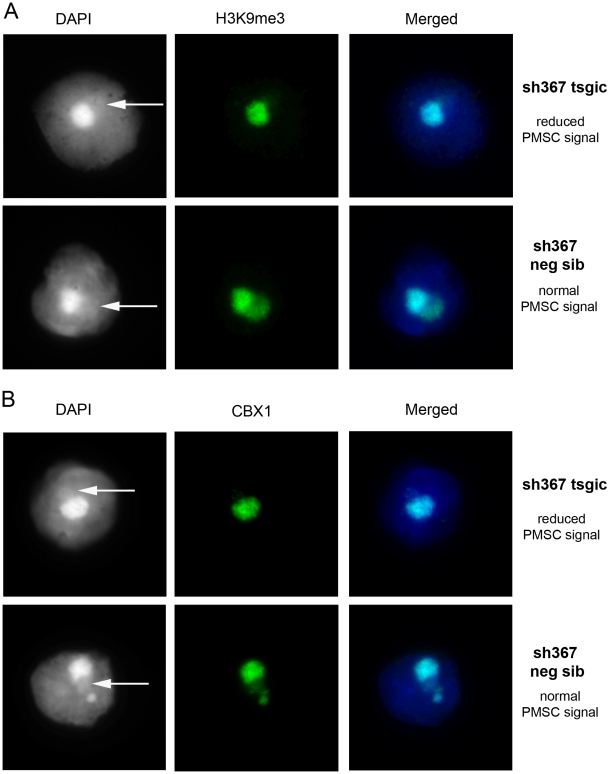
Decreased H3K9me3 and CBX1 staining on the sex chromatin of Sly-deficient spermatids.Detection of (A) H3K9me3 and (B) CBX1 by immunofluorescence in surface-spread round spermatids. DAPI (white, or blue in the merged picture) was used to stain nuclei. The round DAPI-dense structure is the chromocenter. The less DAPI-dense structure at the periphery of the chromocenter is the postmeiotic sex chromatin (PMSC) and is indicated by an arrow. Pictures were taken using the same image capture parameters.